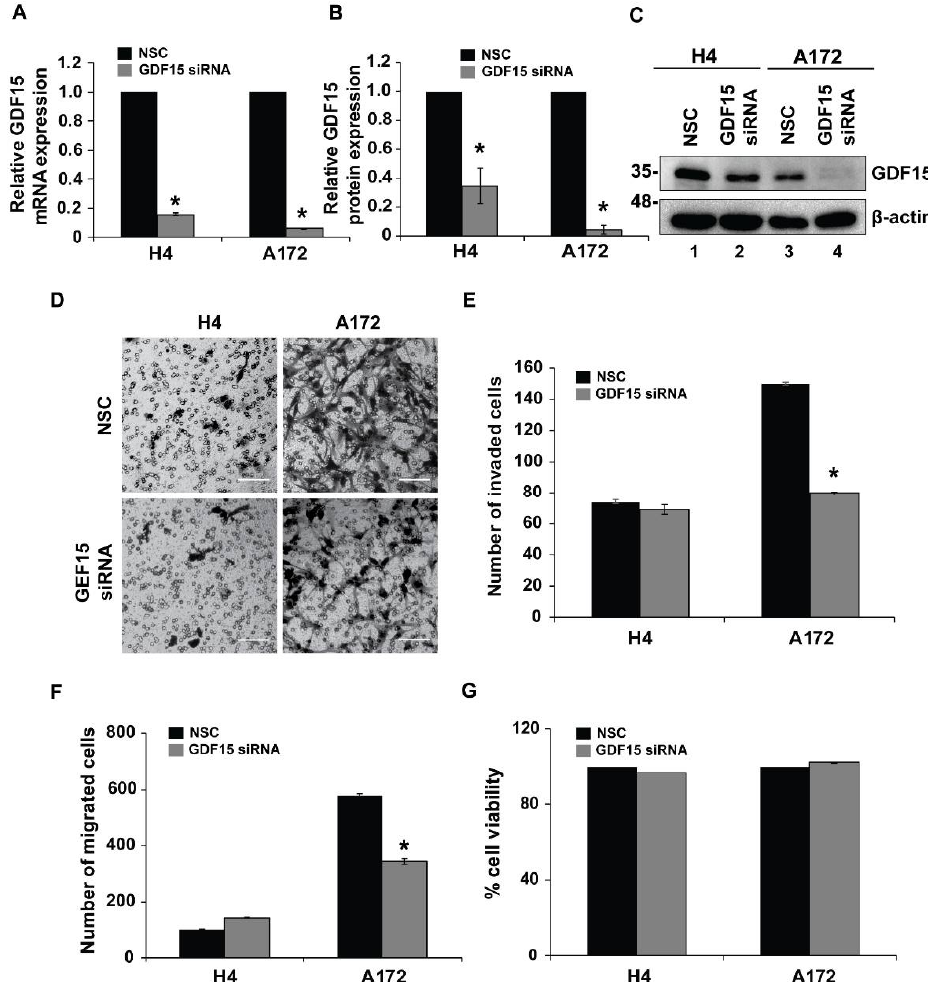
Figure 5. GDF15 silencing does not interfere with cell survival but inhibits cell invasion and migration of the aggressive cell line (A172), whereas it does not affect the non-invasive cell line (H4). ( A ) Relative GDF15 mRNA expression in H4 and A172 after NSC or GDF15 siRNA transfection for 48 h. Three independent real-time PCR experiments were performed and data were analyzed using the ΔΔCt method, with NSC as a calibrator sample for each cell line. ( B ) Quantification of GDF15 protein expression using three different immunoblots. Analysis was performed using NIH ImageJ software. ( C ) Representative picture of Western blot showing the silencing of GDF15 protein after NSC or GDF15 siRNA for 48 h in H4 and A172. ( D ) NSC and GDF15 siRNA treated H4 and A172 cells were subjected to invasion assay 24 h post-transfection. Scale bar: 100 μm. ( E ) Diagram showing the total number of invading glioma cells per transwell in each group (nine randomly chosen microscopic fields per transwell). ( F ) Diagram showing the total number of migrated cells per transwell assessed as described above. For invasion and migration assays three independent experiments were performed and each sample was run in duplicate. ( G ) Graph representing the percentage of cell viability assessed by Alamar blue assay 48 h post GDF-15 siRNA transfection for the two cell lines compared to NSC. Each sample was run in triplicate. Asterisks denote a statistically significant difference ( p < 0.05) compared to NSC data for each cell line.